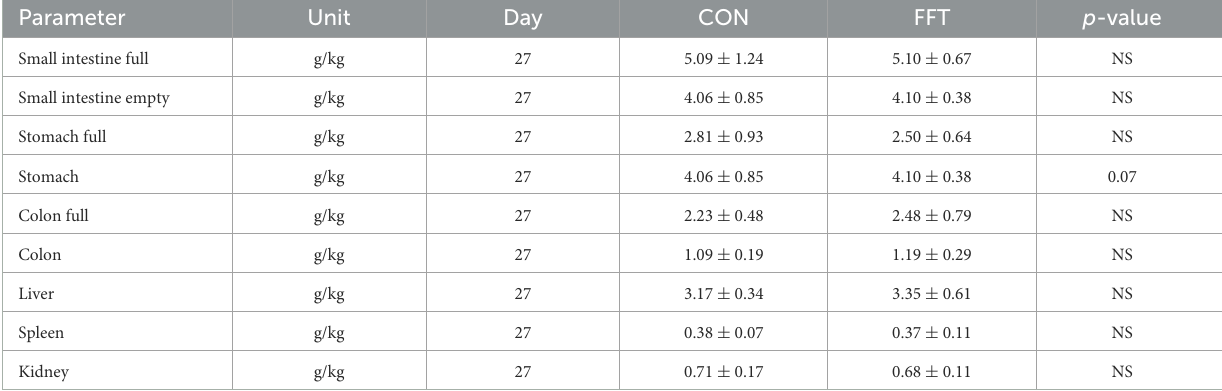
TABLE 4 Relative organ dimensions of piglets euthanized at day 27 ( n = CON: 6; FFT: 7). Parameter